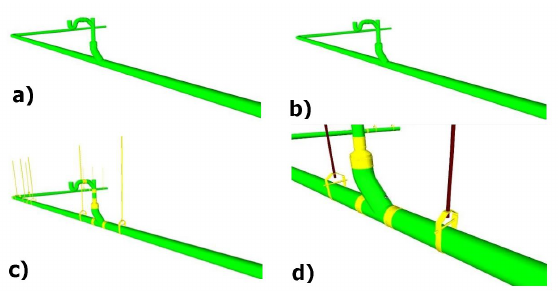
Figure 3 . Example of LoD levels (Sanitary Sewerage Piping): a) LoD200, b) LoD300, c) LoD350, d) LoD400 (source: